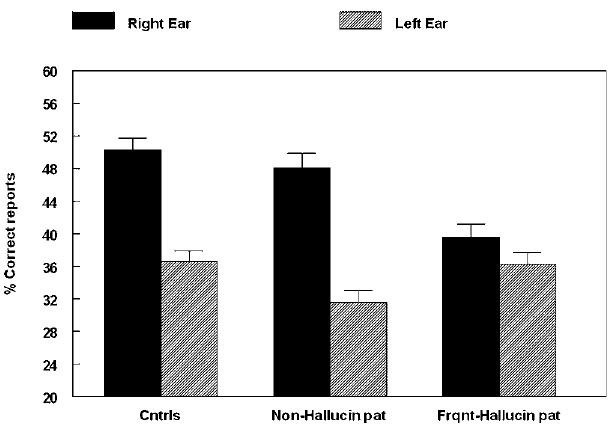
Figure 5. Percent correct reports on the CV-syllables DL paradigm split for right and left ear stimulus presentations, and healthy controls and patients, when the subjects were instructed to focus attention on either the right (“forced-right”) or left (“forced-left”) ear